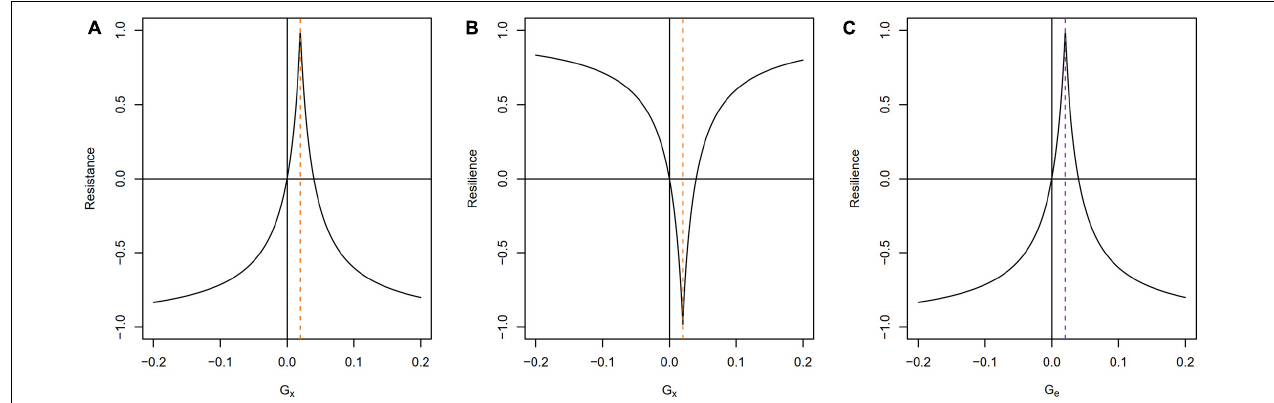
FIGURE 3 | Resistance and resilience as functions of G x and G e . G b is held constant at 0.02 (vertical dashed lines). (A) Resistance is equal to zero for two different values of G x , when G x = 0 and when G x is two times G b . (B) Resilience as a function of G x . Note that different values of G x may return the same Resilience index. (C) Resilience after Orwin and Wardle (2004), with a varying end point (G e ), and constant start (G b ) and minimum (G x ). Resilience equals 1 only when G e = G b . Lower and higher values of G e yield Resilience < 1.